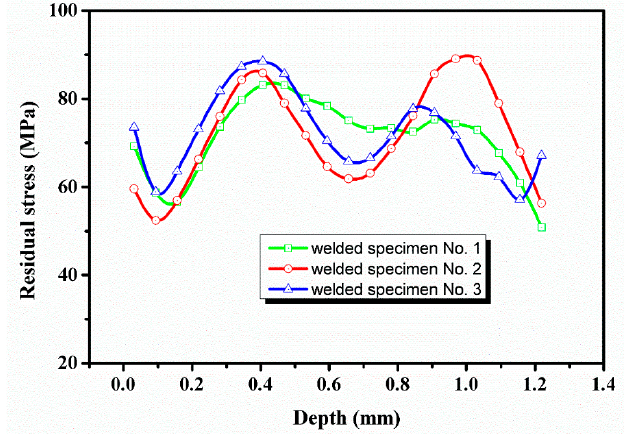
Figure 5. Residual stress distribution along the thickness.